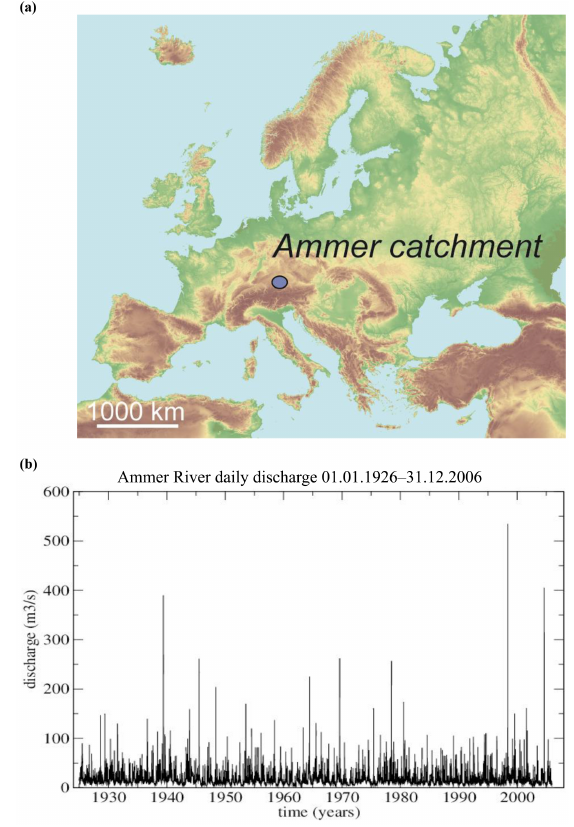
Figure 1. (a) Geographical location of the Ammer catchment and (b) time series of the observed mean daily River Ammer runoff dur- ing the period